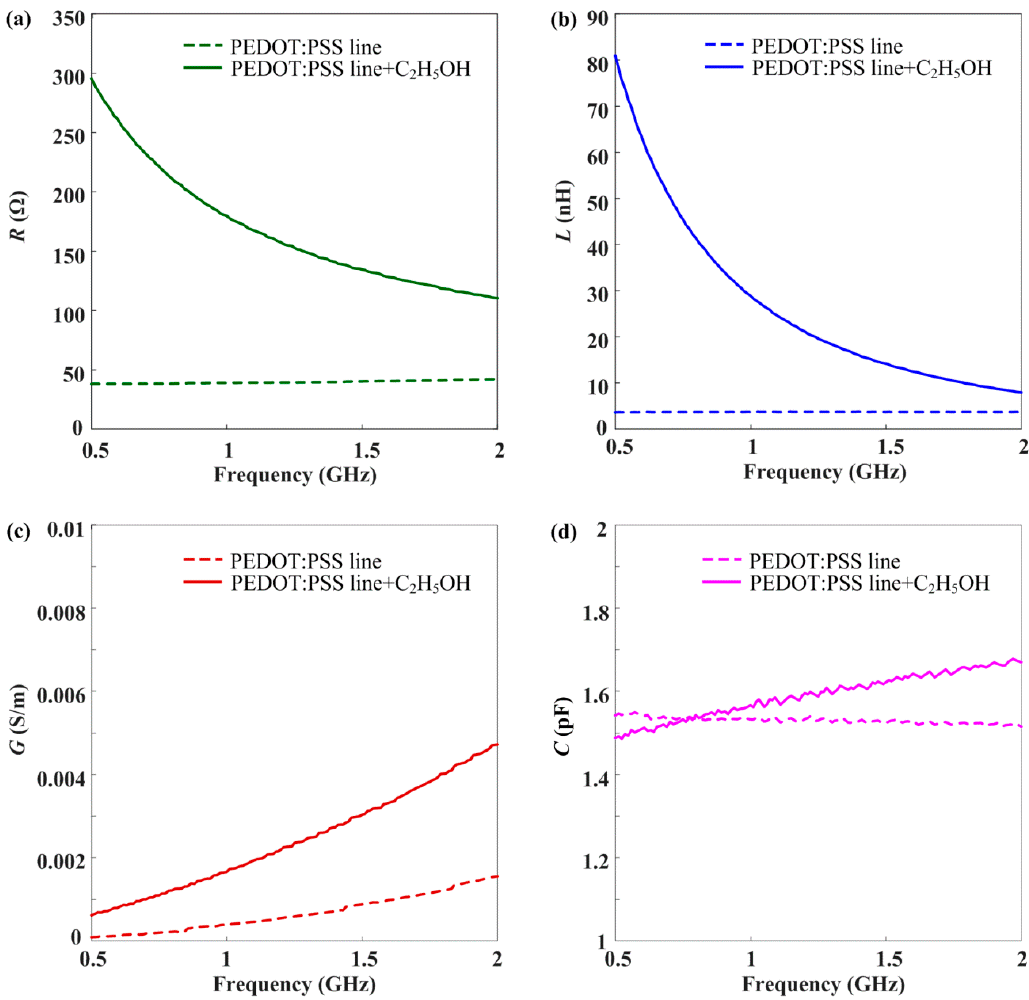
Figure 6. Difference of distributed elements of the PEDOT:PSS line with and without ethanol gas; ( a ) R ; ( b ) L ; ( c ) G ; ( d ) C component.